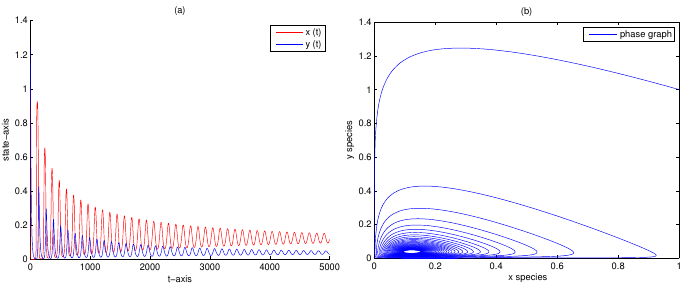
Figure 7. Equilibrium status ˜ E ∗ of Model (2) with f = 1000 is numerically unstable: ( a ) time-series curves of x ( t ) and y ( t ) and ( b ) phase